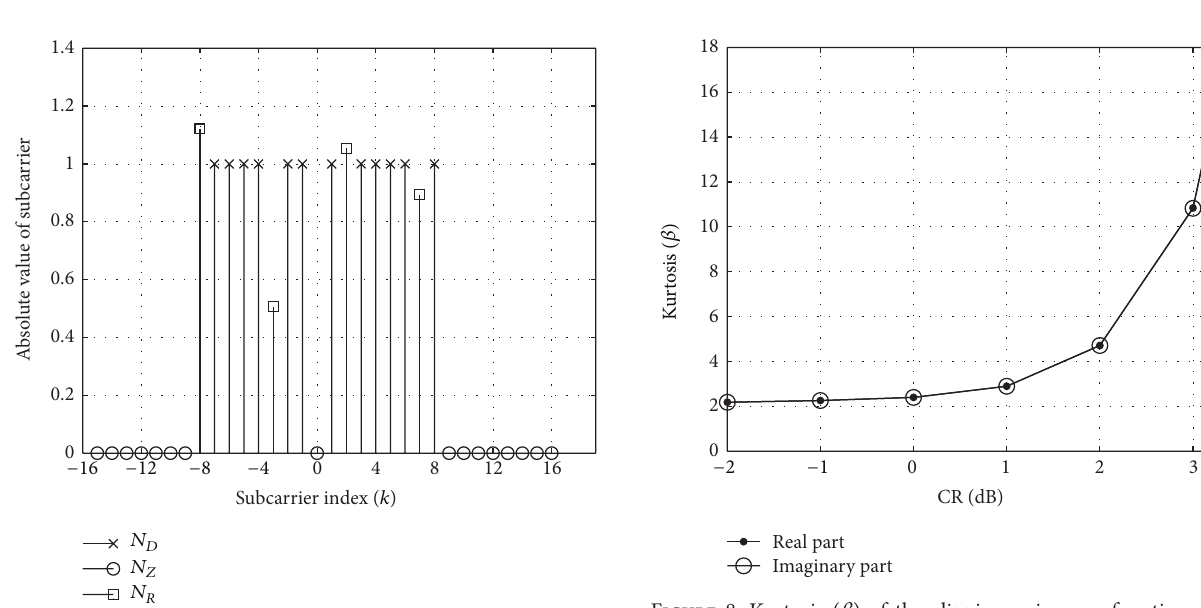
Figure 6: Block diagram of the clipping based PAPR reduction schemes.